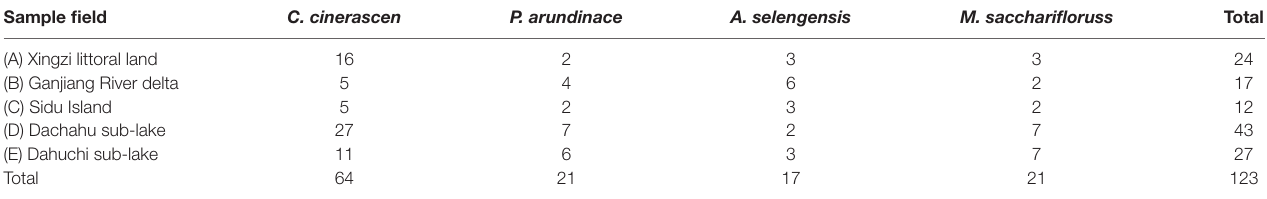
TABLE 2 | The number of sample sites in every sample field in 2016.